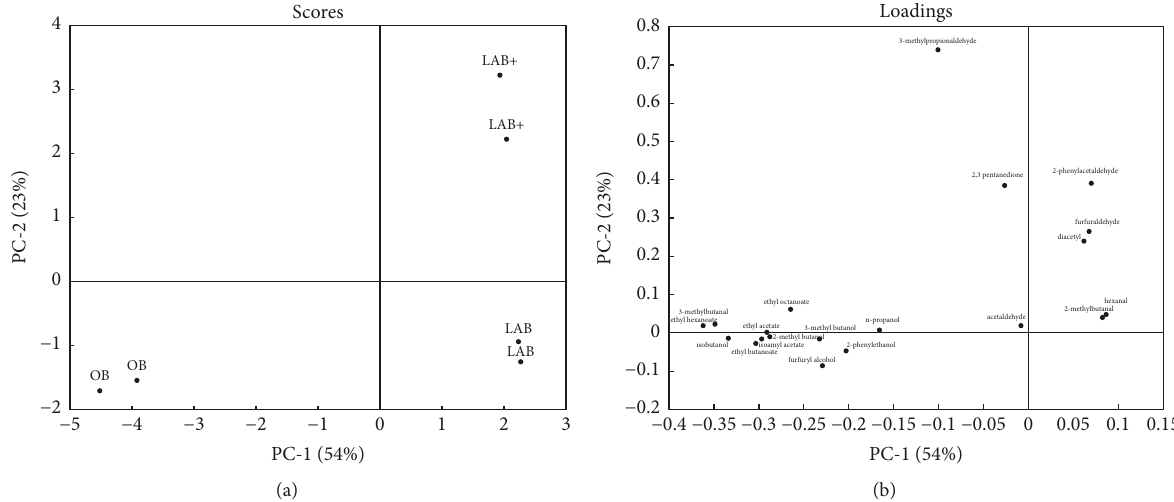
Figure 3: PCA plots of volatile compounds of OB, LAB, and LAB+ samples: (a) score plot and (b) loading plot.